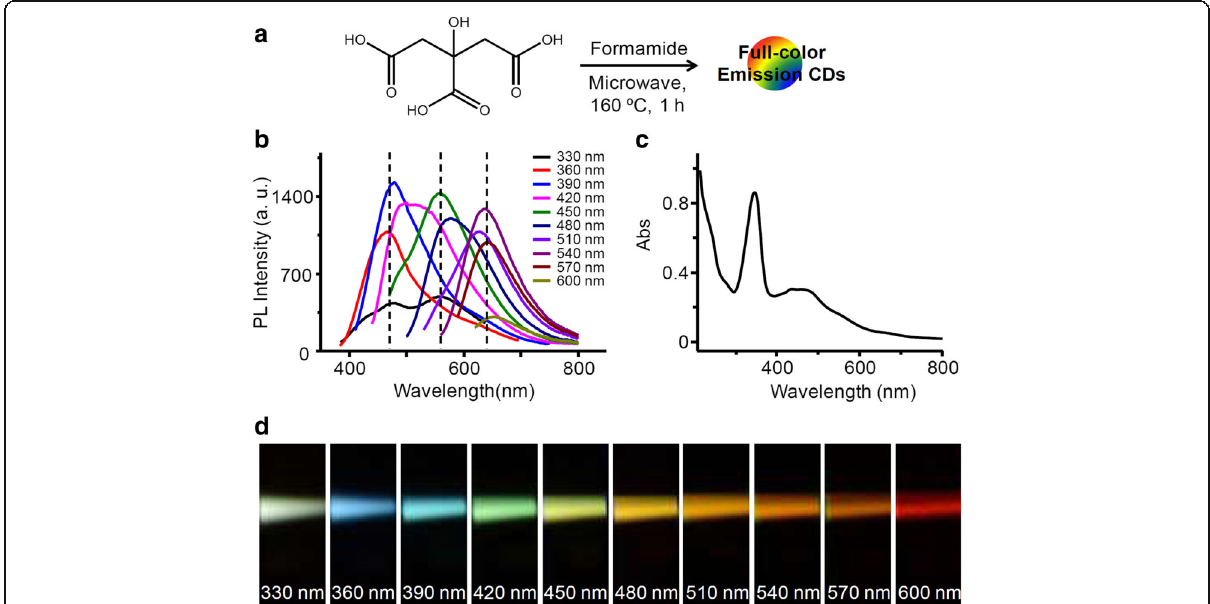
Fig. 5 a Schematic of the preparation of the full-color-emission CDs. b Fluorescence spectra of the fluorescent CDs (F-CDs) under different excitation wavelengths. c UV-vis absorption spectra of the F-CDs. d Fluorescence emission photographs of the F-CDs recorded from 330 to 600 nm in 30 nm increments. All spectra and photographs were obtained in deionized H 2 O [60]